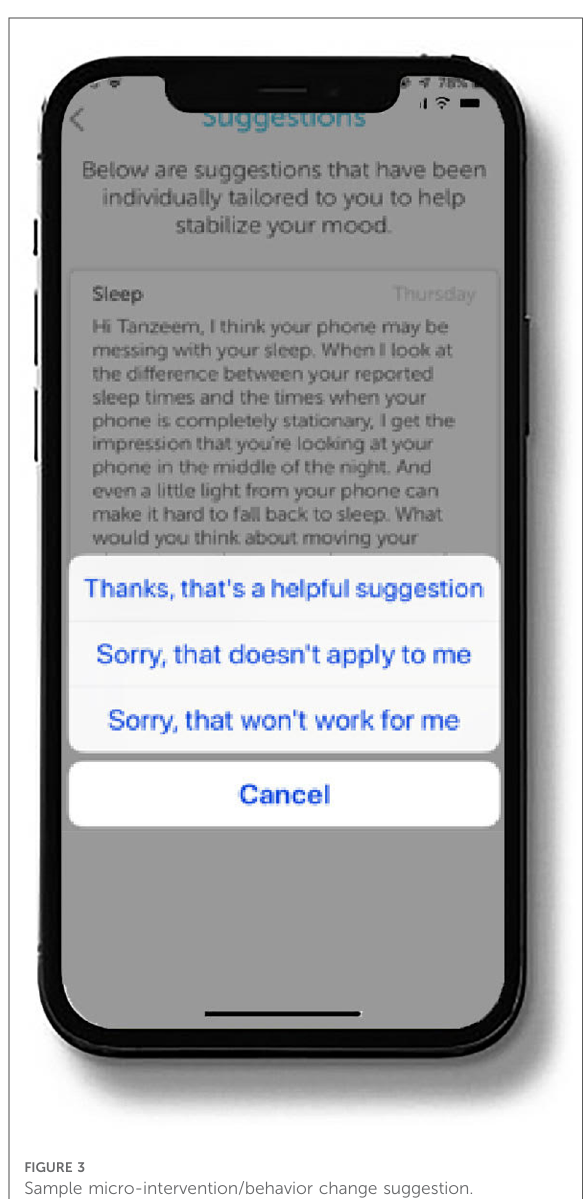
FIGURE 3 Sample micro-intervention/behavior change